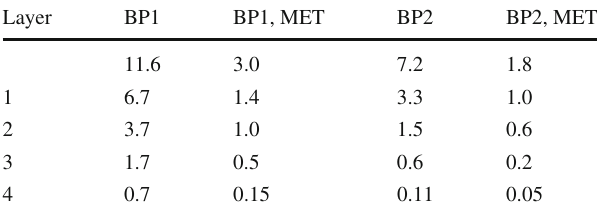
Table 2 The number of charginos leading to displaced leptons, which reach each of the layers of the pixel detector of CMS or ATLAS. The values are given for a total integrated luminosity of 6000 fb − 1 . In the columns with MET a requirement of / E T > 150 GeV has been